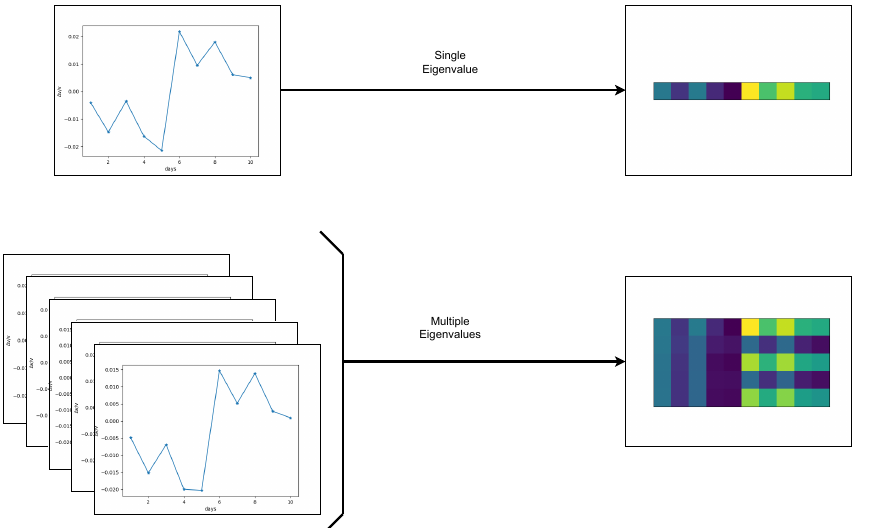
Figure 2. For the purpose of this work, ∆ ν / ν measurements are used to form the MIMs which are images of m d pixels. Here, m denotes the number of natural modes monitored and d the number of × days over which they are monitored. Here, we illustrate MIMs using either one ( top ) or five ( bottom ) natural modes monitored over a 10 day